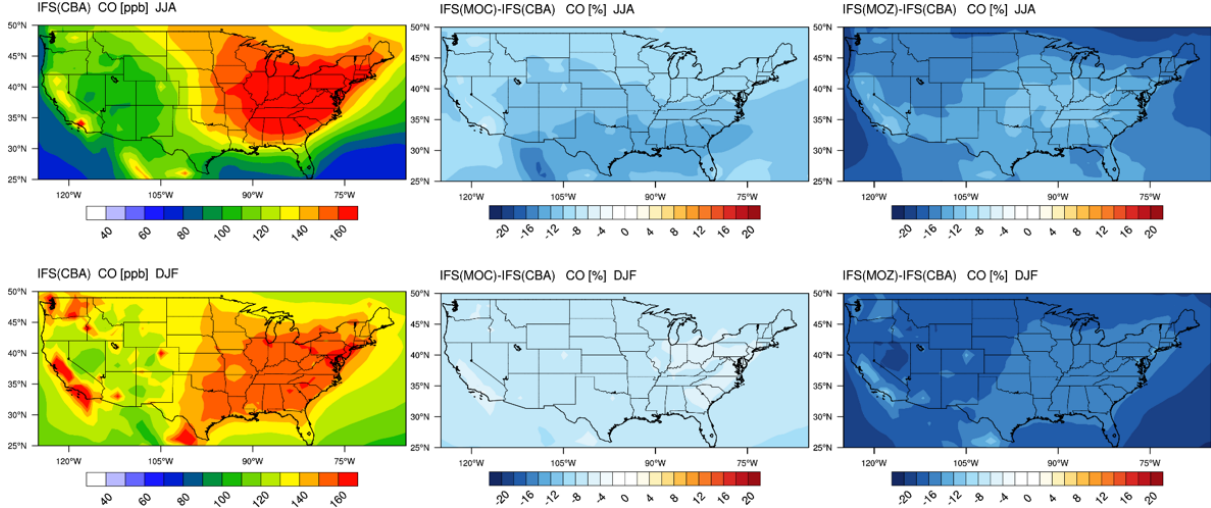
Figure 7. The horizontal mean cross section of CO below 1km over the US domain for JJA 2014 (top) and DJF (2014/2015).